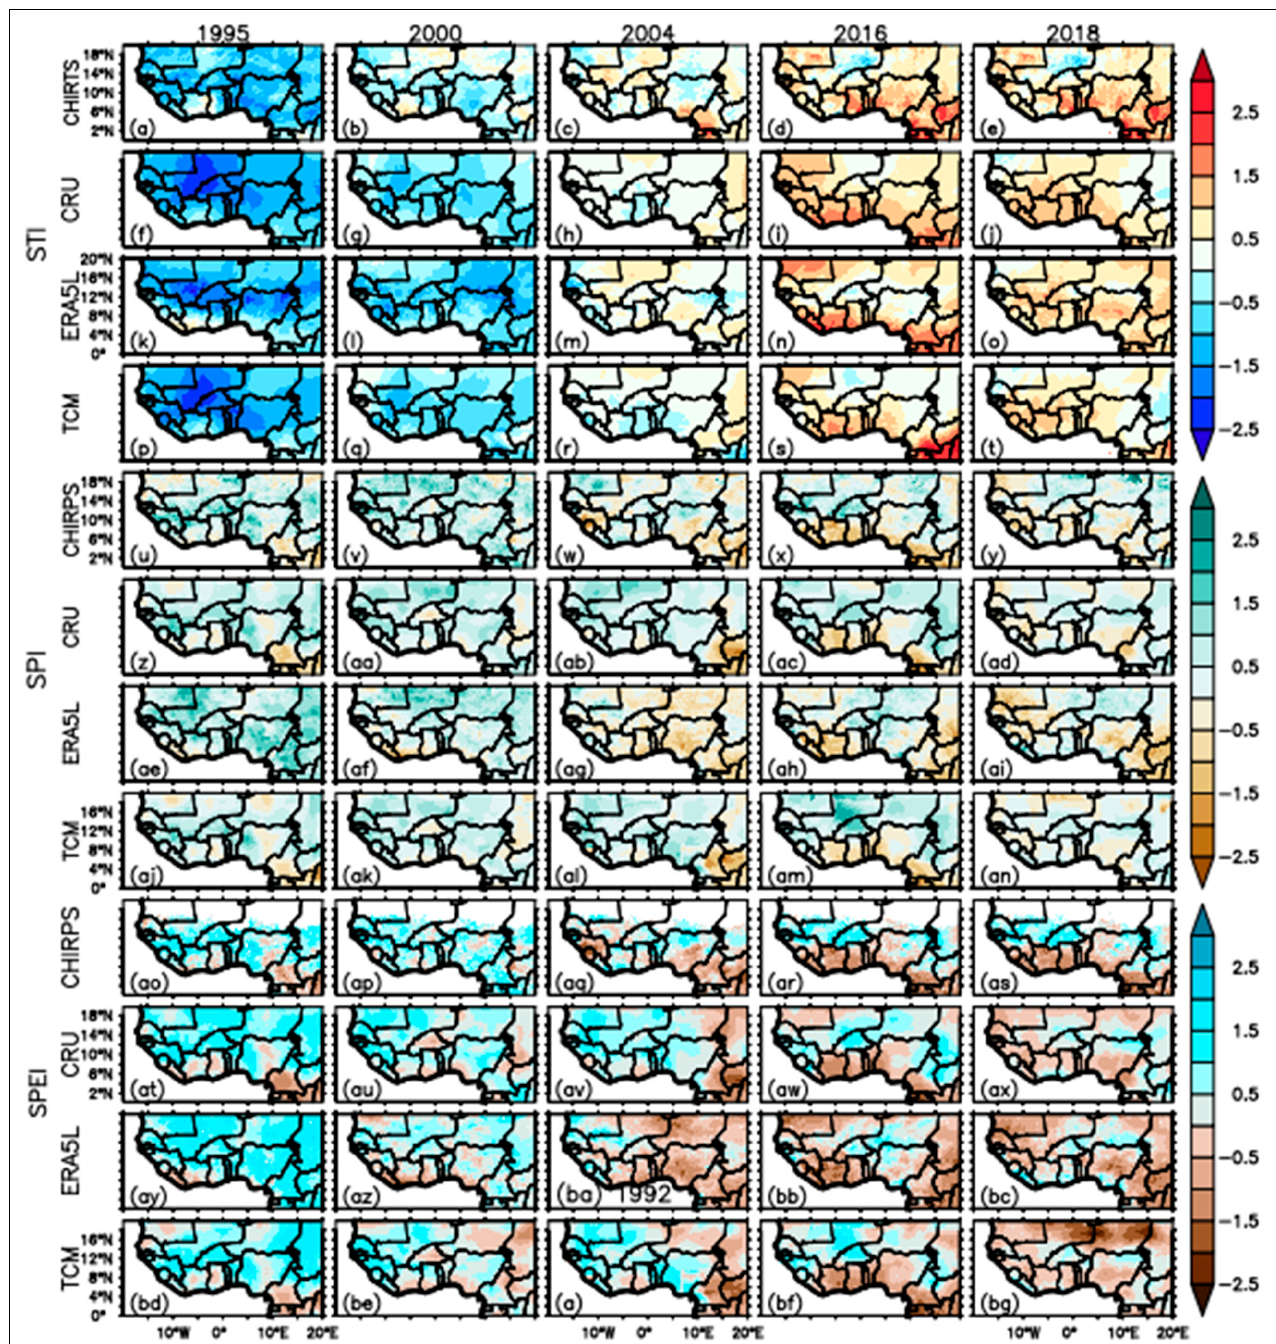
Figure A2. ( a – bg ) Climatic conditions during abrupt land cover changes.